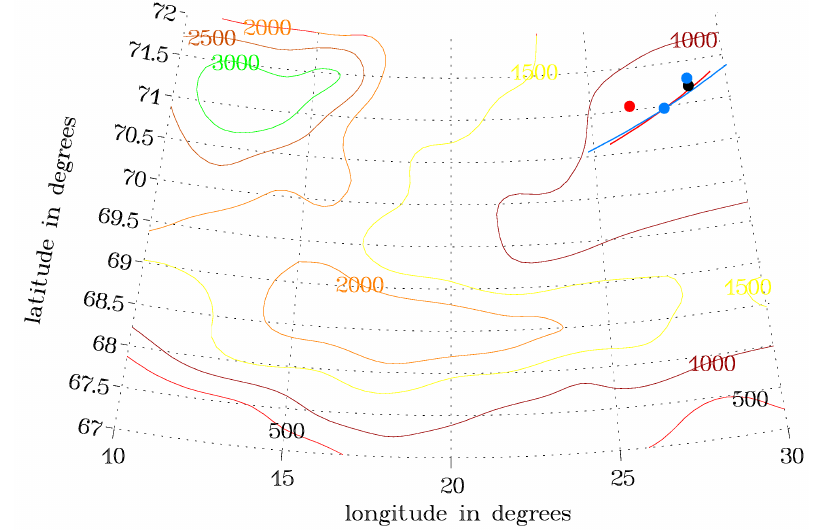
Fig. 8. Cluster footprints (dots, colours as in Fig. 1), and direction estimates of the flux rope as mapped to the ionosphere (blue line: based on 90 ◦ rotated TCR direction of motion; red line: based on the orientation measured by Cluster 3; in both cases linearly continued in the magnetospheric X-Y plane) at 22:59:50 UT, together with WIC emissions in R at 22:58:41 UT (iso contour